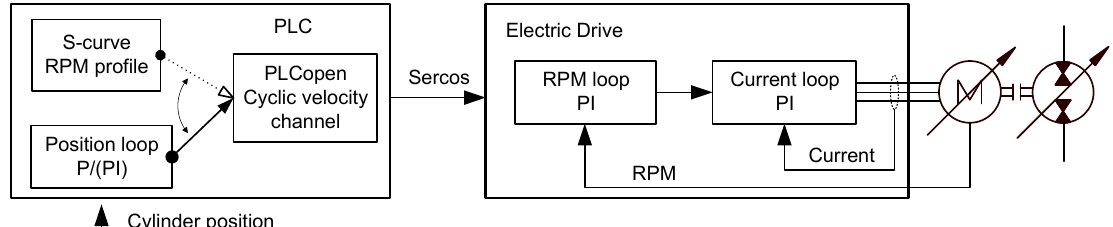
Figure 3. Control structure of the DDH system.